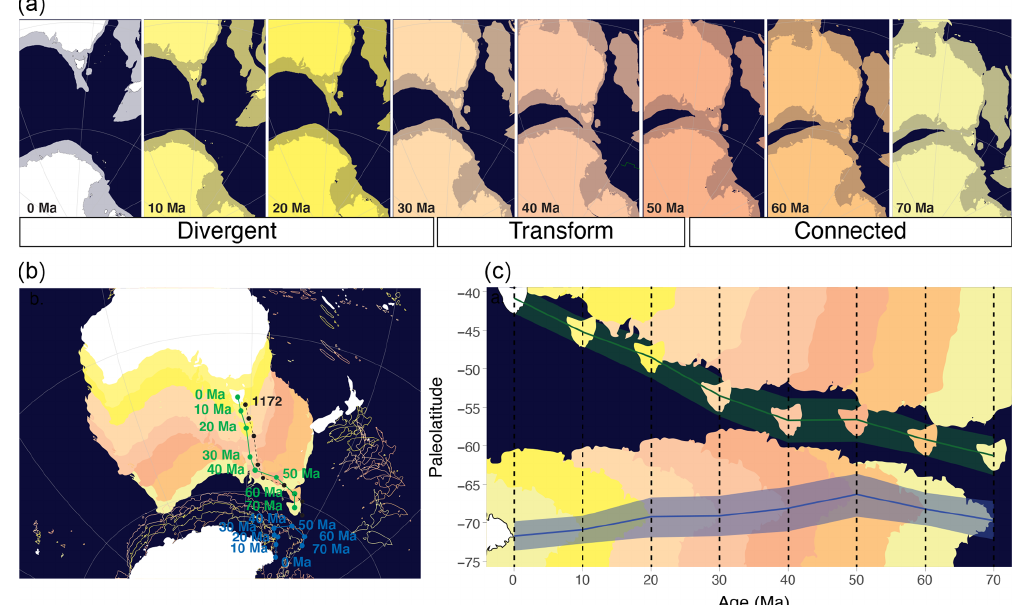
Figure 1. Absolute plate tectonic changes around Tasmania during the Maastrichtian to a recent era. (a) Tasmanian Gateway (TG) opening in eight time slices, present to 70Ma. Relative tectonic motion between Australia and Antarctica is limited until about 53Ma, transform until 34Ma and divergent from 34Ma onwards. (b) Like panel (a) but on an orthographic projection (compiled with Gplates, using a paleomagnetic reference frame (Torsvik et al., 2012) from Seton et al., 2012). Green and blue lines and dots represent the pathways of Tasmania and Cape Adare, respectively; the dashed black line and dots represent the paleoposition of Site 1172. (c) The absolute paleolatitude of Cape Adare, Antarctica (blue line; blue shading indicates uncertainty), as indicative of the plate tectonic motion around the pathway of the Tasman Current, and of Tasmania (green line; green shading indicates uncertainty), as indicative of the plate tectonic motion of the source area of the terrestrial organic matter, in 10Myr time steps from 70–0Ma, obtained from http://paleolatitude.org (last access: 10 November 2021) (Van Hinsbergen et al., 2015). Plate contours represent paleolatitude of present-day shorelines for orientation (obtained from Gplates). Note that, in the visualizations in panels (b) and (c) , submerged continental crust is not shown but does limit TG